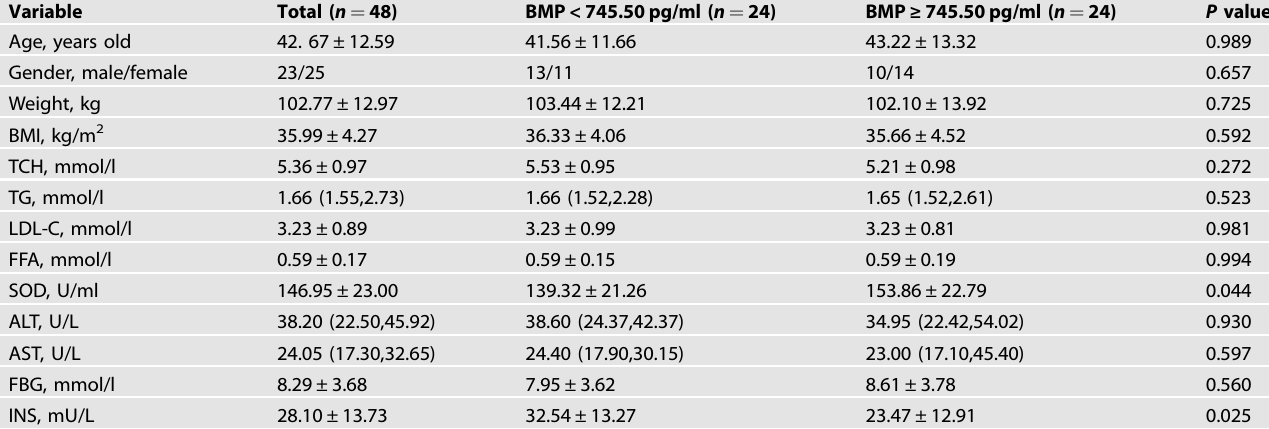
Table 1. Demographic and laboratory data of the patients with